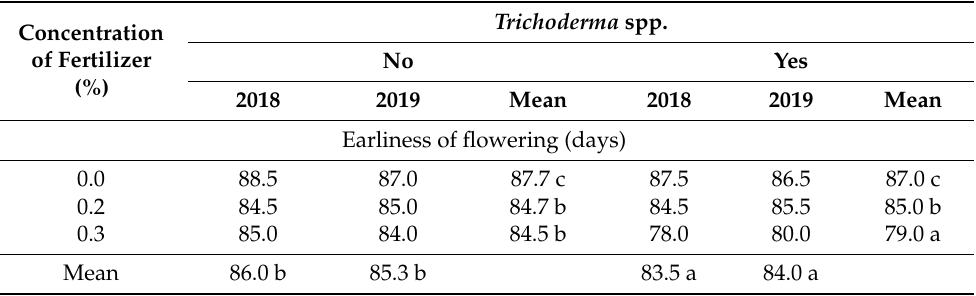
Table 2. Earliness of flowering and quality of plants of Begonia × tuberhybrida ‘Picotee Sunburst’ after application of Trichoderma spp. and different fertilization level. Means followed by the same letter for column-wise and row-wise do not differ significantly at α =